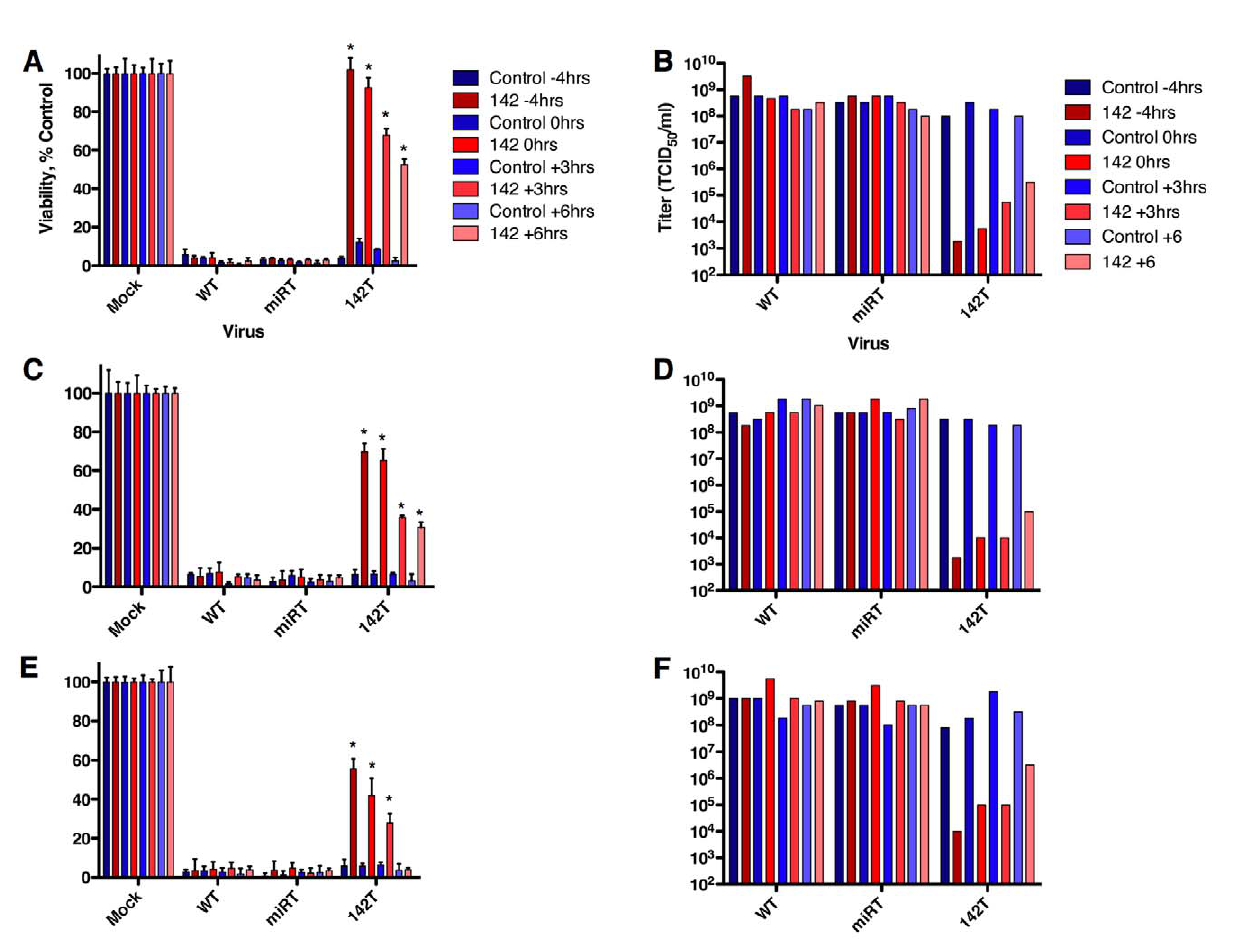
Figure 3. MicroRNAs inhibit late-stage picornavirus infections. Viability 48 hrs. post infection with (A) MOI=1.0, (C) MOI=3, (E) MOI=10 CVA 142T in the presence of control or miR-142-3p mimic added 4 hours prior to infection, or at 0, 3, or 6 hours post infection. (B) Viral yield from cell supernatant as measured by TCID 50 assay from (A) on H1-HeLa cells. (D) Viral yield from cell supernatant as measured by TCID 50 assay from in (C) on H1-HeLa cells. (F) Viral yield from cell supernatant as measured by TCID 50 assay from (E) on H1-HeLa cells. *p= , .01 (as compared to H1-HeLa + Control).